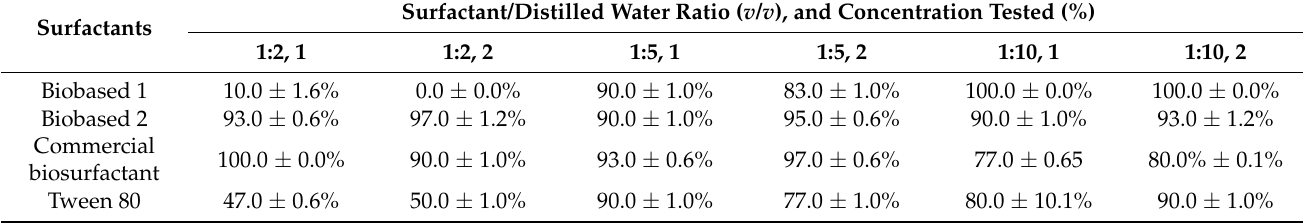
Table 4. Survival rate (%) of Artemia salina larvae in the presence of surfactant solutions diluted in the 1:2, 1:5, and 1:10 ( v / v ) of surfactant/distilled water ratios and used at concentrations of 1 or 2%.